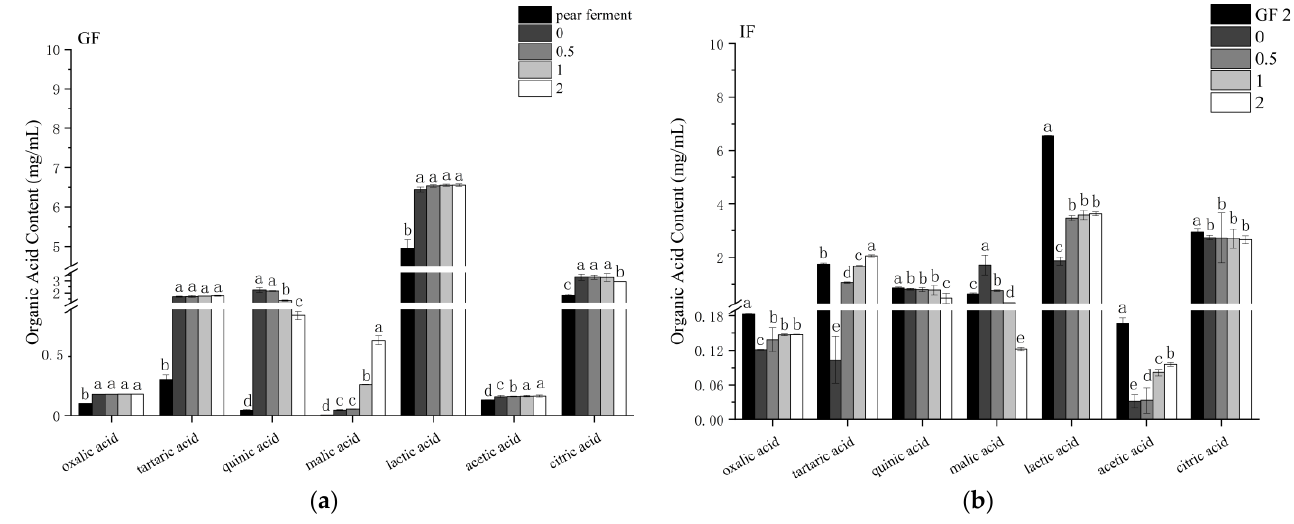
Figure 10. Changes of organic acids of ‘Xuehua’ pear ferment during the simulated digestion in vitro. ( a ) indicates simulated gastric digestion; ( b ) indicates simulated intestinal digestion. Different letters indicate significant differences in the same group under different digestion times ( p < 0.05). Data shown as means ± SD of three replicates ( n = 3).